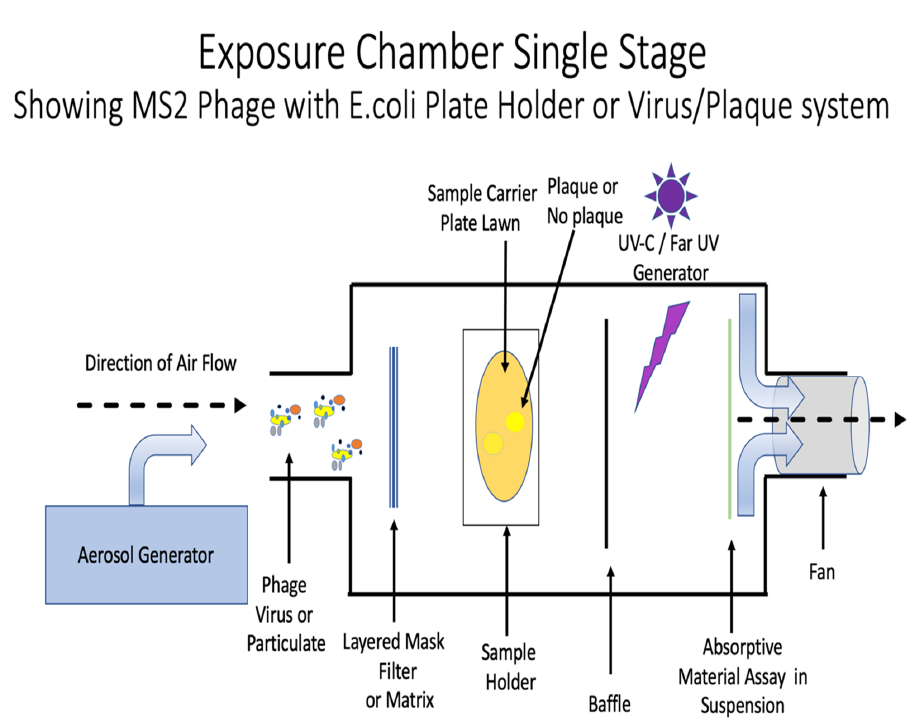
Figure 2. Testing and exposure chamber designed with MS2 phage and other viroids.